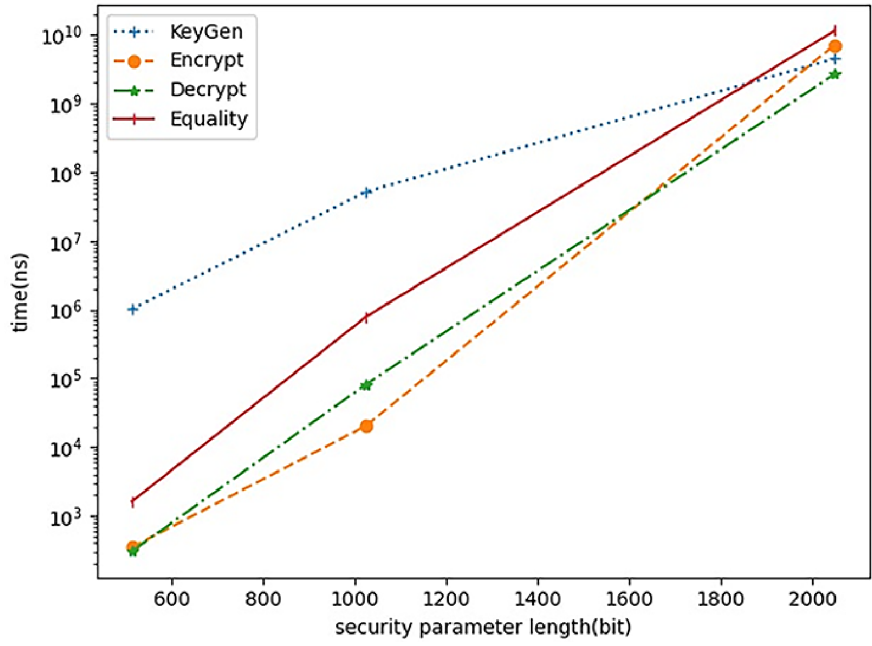
Fig 3. The performance of the proposed scheme.